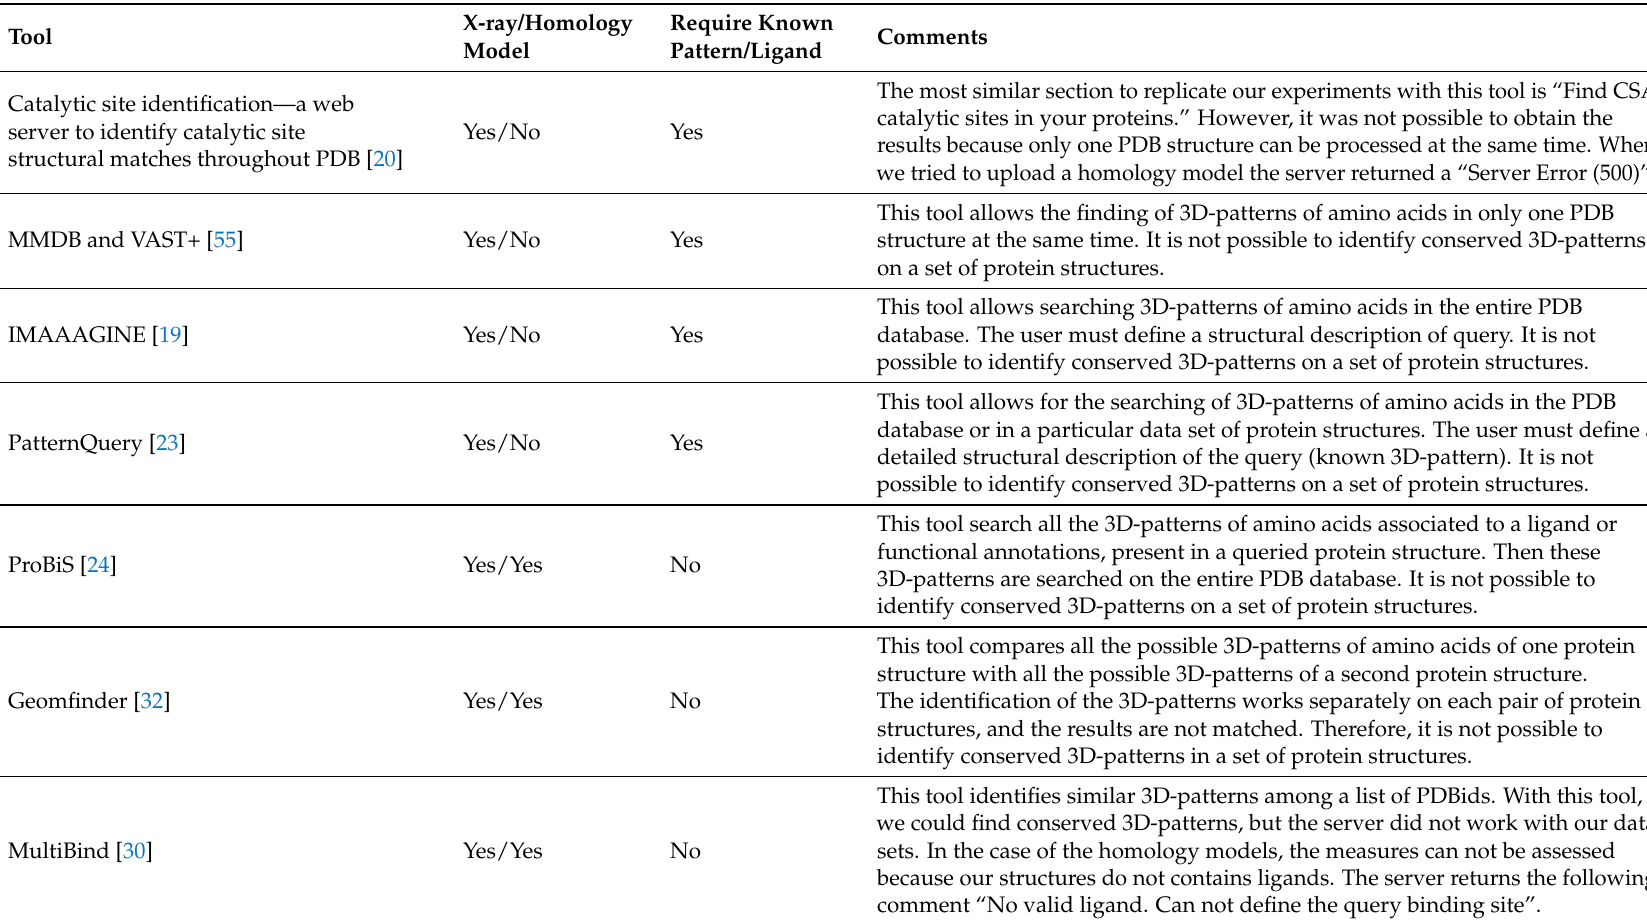
Table 2. Comparative table of similar